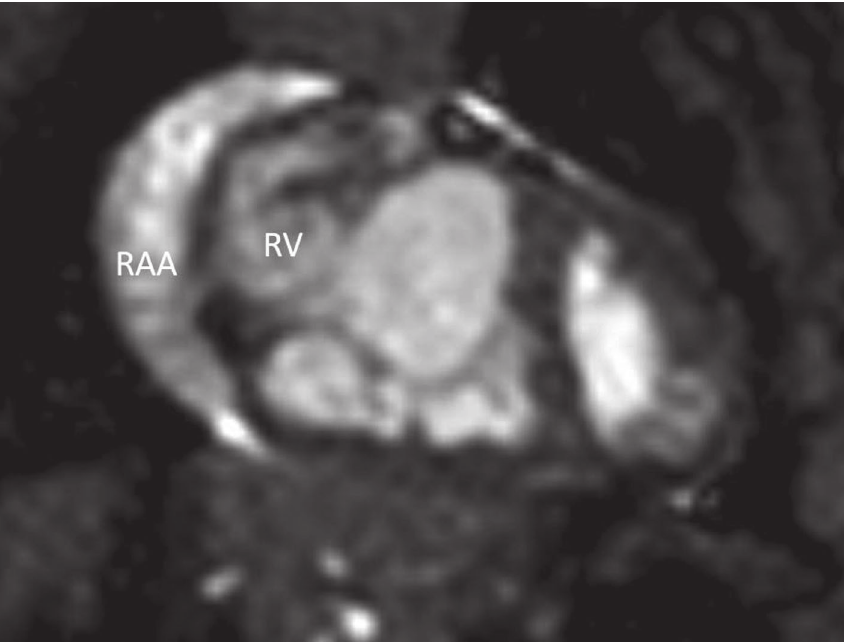
Figure 5: A coronal cine SSFP image from cardiac magnetic resonance of the trabecular, hypoplastic RV and the large atrialized portion of the RV. The dilated right atrial appendage (RAA) is also